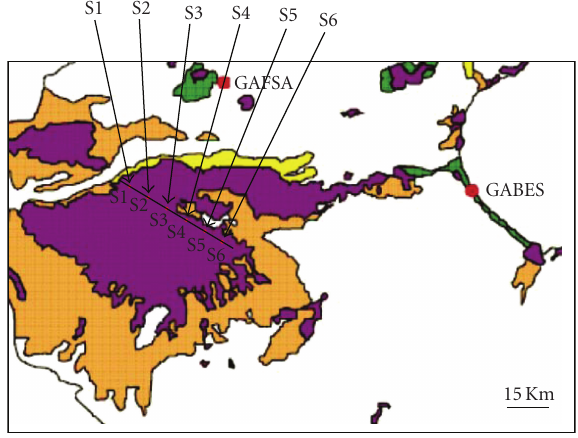
Figure 1: Site map of the El-Djerid lake (Tunisia) and sampling